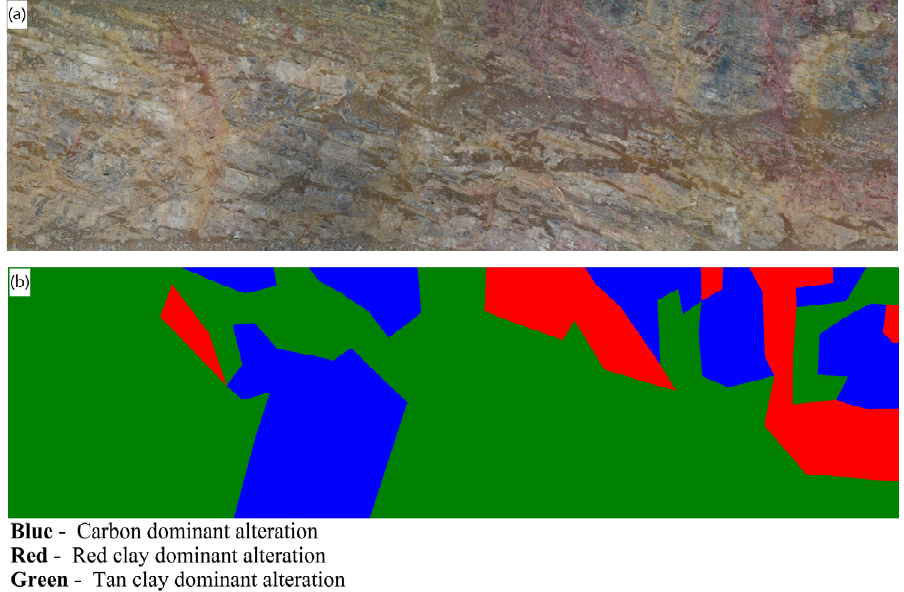
Figure 5. ( a ) The orthomosaic of the selected pit wall section for Pick Pit (complex case). ( b ) The corresponding “novice-labelled” ground truth map.